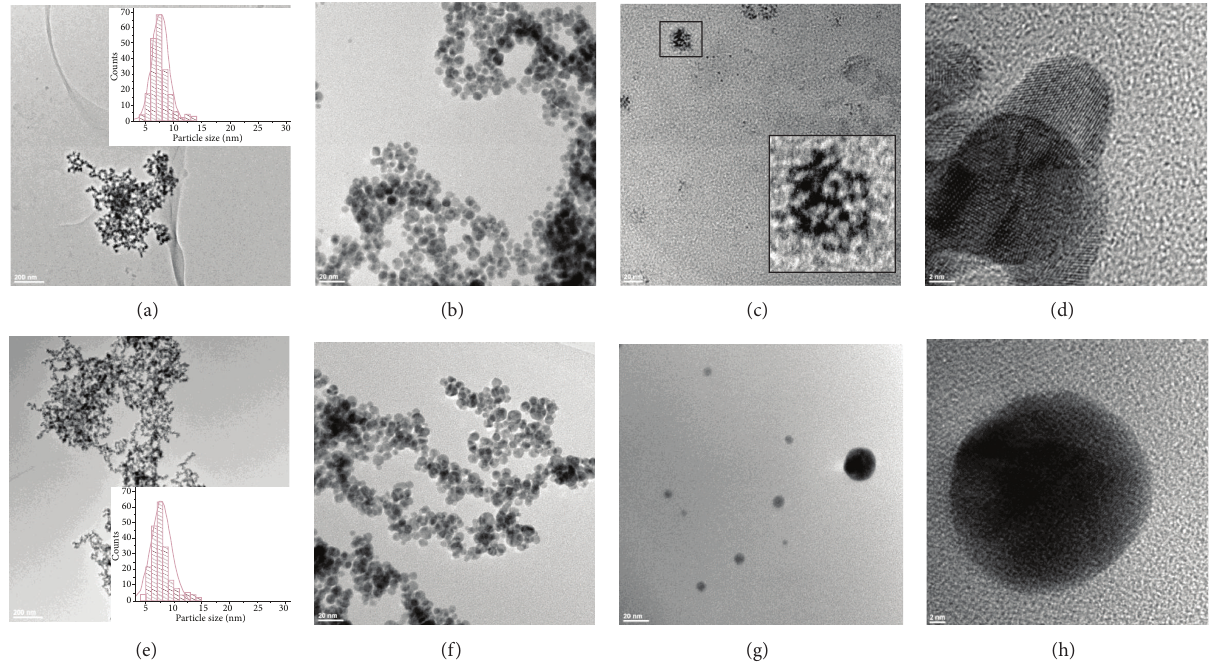
Figure 9: TEM and HR-TEM micrographs of Au-G6-1 nanocomposites: (a)–(d) after 60 minutes and (e)–(h) after 48 hours. (a), (e) Clusters of nanoparticles; (b), (f) chain-like structures of nanoparticles; (c) area with limited number of metal atoms accumulated inside PAMAM-G6 molecules; inset in (c) is a detailed view of the marked area from this image, and it shows gold domains inside one dendrimer molecule; (d) crystalline nanoparticle with adjacent crystalline structures; (g) small metal particles; (h) one nanoparticle. Size-distribution histograms are included as insets in (a), (d).